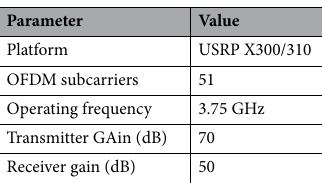
Table 1. Software configuration and parameters’